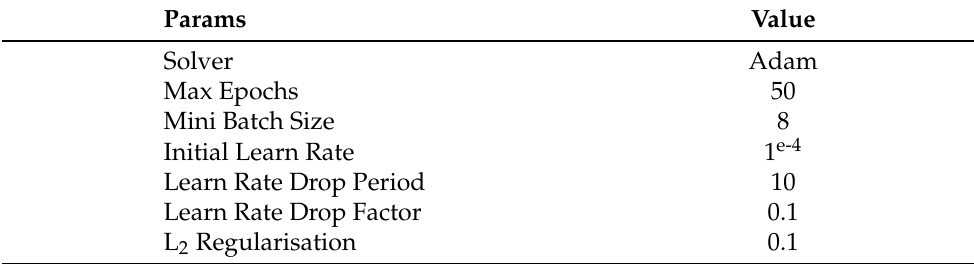
Table 1. Hyper-parameters settings for CNNs